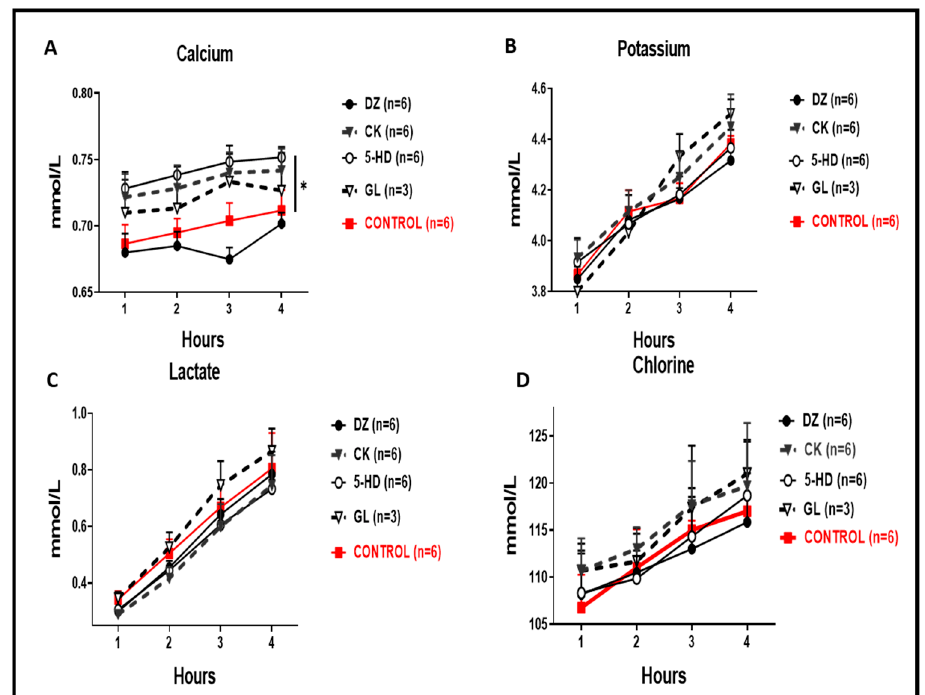
Figure 5. Clinical biochemistry of the perfusate. ( A ) Calcium perfusate concentrations were signifi- cantly higher in 5-HD and CK compared to the control (* p < 0.05). ( B ) Concentrations of potassium in the perfusate were not significantly different in any condition compared to the control. ( C ) Lactate levels in all conditions were comparable to the control. ( D ) Chlorine levels in all conditions were comparable to the control.